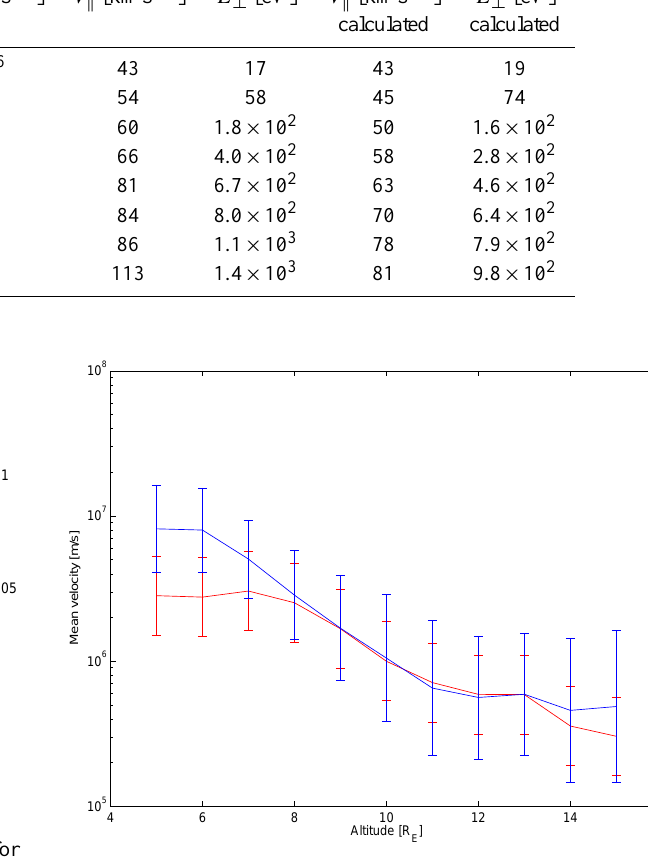
bars show the standard deviation for the logarithmic values. velocity are equal. Lower panel: number of data points contributing when the phase velocity E/B and the calculated Alfv´en velocity are